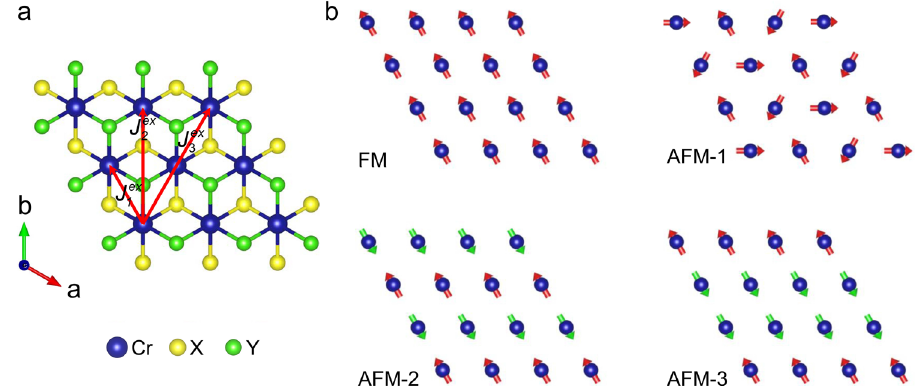
Fig. 1 Geometrical and magnetic con fi guration of CrXY monolayer. a 1T phase chromium sul fi de halide CrXY monolayer crystal structure and the magnetic exchange paths. b Four different magnetic spin ordering con fi gurations are involved. The blue, yellow and green balls represent the Cr atom, chalcogen atom (X) and halogen atom (Y), respectively. Table 1. Energies of CrXY monolayers.